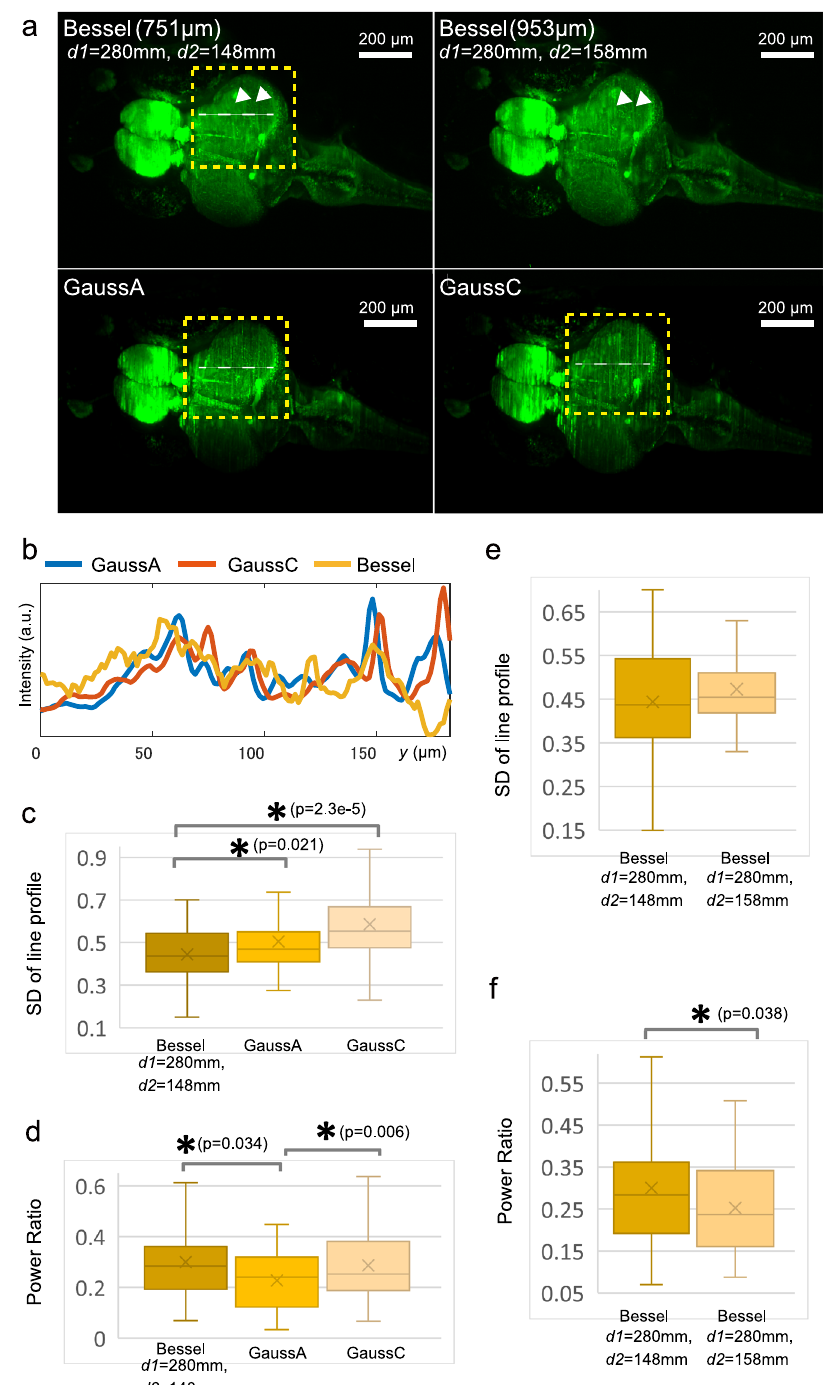
Fig. 4 Application of the tunable Bessel beam DSLM. a Comparison of the brain image between the Gaussian and Bessel beams. Larvae of the Kif5Aa- EGFP strain, which expresses EGFP in neuronal cells 35 , are used. Images shown are acquired using the same larva. Yellow rectangles indicate the area where signi fi cant differences appear in the comparison of Gaussian and Bessel beam irradiations. White arrow heads indicate the area where signi fi cant differences appear in the comparison of different Bessel beam irradiations. Scale bar, 200 μ m. n = 5 biologically independent larvae are subjected to the analysis. b Line pro fi les along the white lines in ( a ). a.u. arbitrary unit. c Standard deviations of the line pro fi les. d Ratio of the power spectra of the object smaller than 20 μ m to that of the total. e Standard deviations of the line pro fi les for the Bessel beam ( d 1 = 280 mm and d 2 ¼ 148 mm) and ( d 1 = 280 mm and d 2 ¼ 158 mm). f Power ratio for the Bessel beam ( d 1 = 280 mm and d 2 ¼ 148 mm) and ( d 1 = 280 mm and d 2 ¼ 158 mm). c – f In the box plots, the lines of the box indicate the fi rst quantile, median, and third quantile. Upper and lower whiskers indicate the minimum and maximum, respectively. The Cross mark represents the average. The asterisk indicates a p value <0.05 with one-sided t -test. Degrees of freedom for the t -test is 29. c – f For the analysis, six independent line pro fi les are extracted from n = 5 biologically independent larvae. In total, 30-line pro fi les are subjected to the analyses.